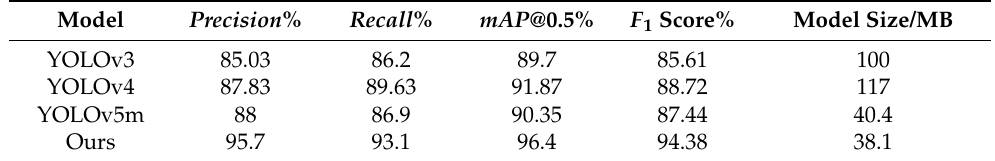
Figure 10. P-R curve of original YOLOv3, YOLOv4, YOLOv5m, and improved YOLOv5m, where the x -axis represents Recall , and the y -axis represents Precision . Table 3. Comparison of experimental results for YOLOV3, YOLOv4, YOLOv5m, and proposed model with different performance indicators such as Precision , Recall , mAP , F 1 score, and model